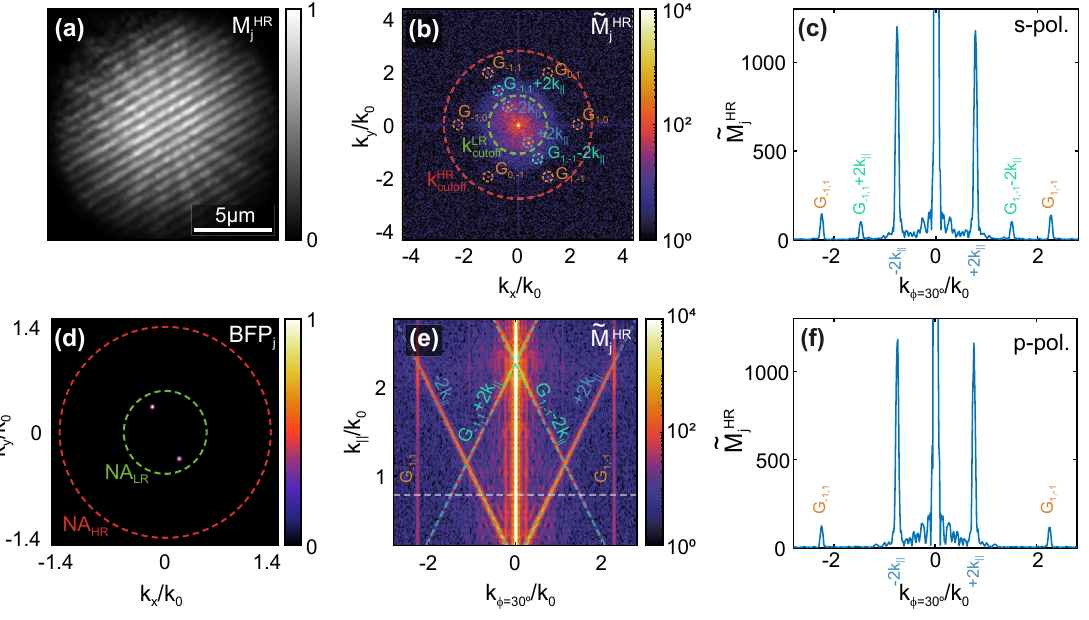
Figure 6: Experimental double moiré localized plasmon SIM (DM-LPSIM) illumination characterization. (a)DM-LPSIMmeasurementwiths-polarization, θ glass =15 ° and ϕ =30 ° .(b)2DFouriertransformof(a).Thegreendashedcircleindicates k LR andthereddashedcircle k HR .(c)1Dpro fi lealong ϕ =30 ° in(b).(d)A measurementofthetwoincidentbeamsinthebackfocalplane(BFP)of cutoff the objective. (e) Sweep of 1D pro fi les along ϕ = 30 ° for a varying in-plane wave vector k || ( y -axis). (f) 1D pro fi le along ϕ = 30 ° a Fourier transformed DM-LPSIM measurement featuring p-polarization. Note, panels (b) and (e) are shown on a logarithmic color